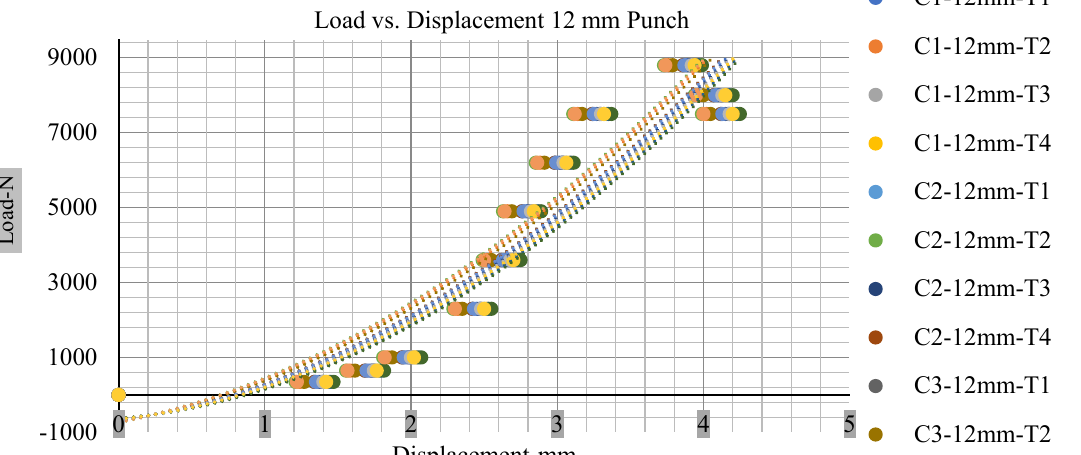
Figure 15. Load vs. displacement 25 mm low to peak loads. Thus, short circuit, punch displacements with greater than 10% SOC at onset are 2.952 mm, 3.712 mm, 5.529 mm, and 6.503 mm, and, similarly for less than 10% soc, 3.88 mm, 5.42 mm, 5.94 mm, and 6.92 mm for a small, medium, large, and a flat cylindrical punch. In less than 10% soc, the flat cylindrical punch has a diameter of 28 mm, in which the short circuit force initiates no drop in.